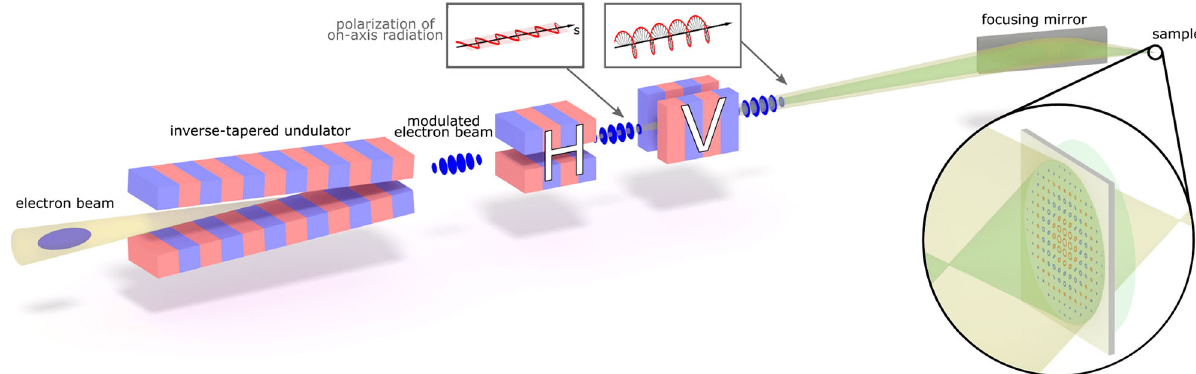
FIG. 4. Illustration of the scheme to deliver radiation with spatial polarization shaping. The density-modulated electron beam sequentially radiates in planar undulators set to horizontal and vertical polarization. After passing the imaging system depicted here as a single lens radiation is focused into two waists of orthogonal polarizations. The sample is introduced between the waists where spherical wavefronts of the two radiation beams have the opposite curvature. This results in spatially-dependent phase difference, hence spatially shaped polarization at the sample.